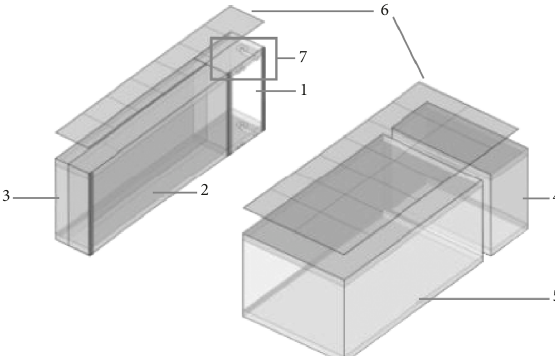
Figure 1: Modular prefabricated building prototype (source: au- thors’ own data).